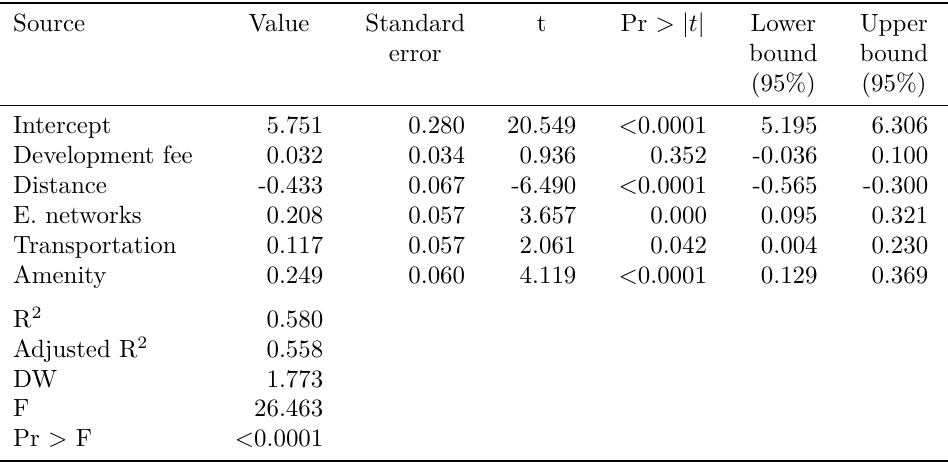
Table 1: General estimation results (Model 1)